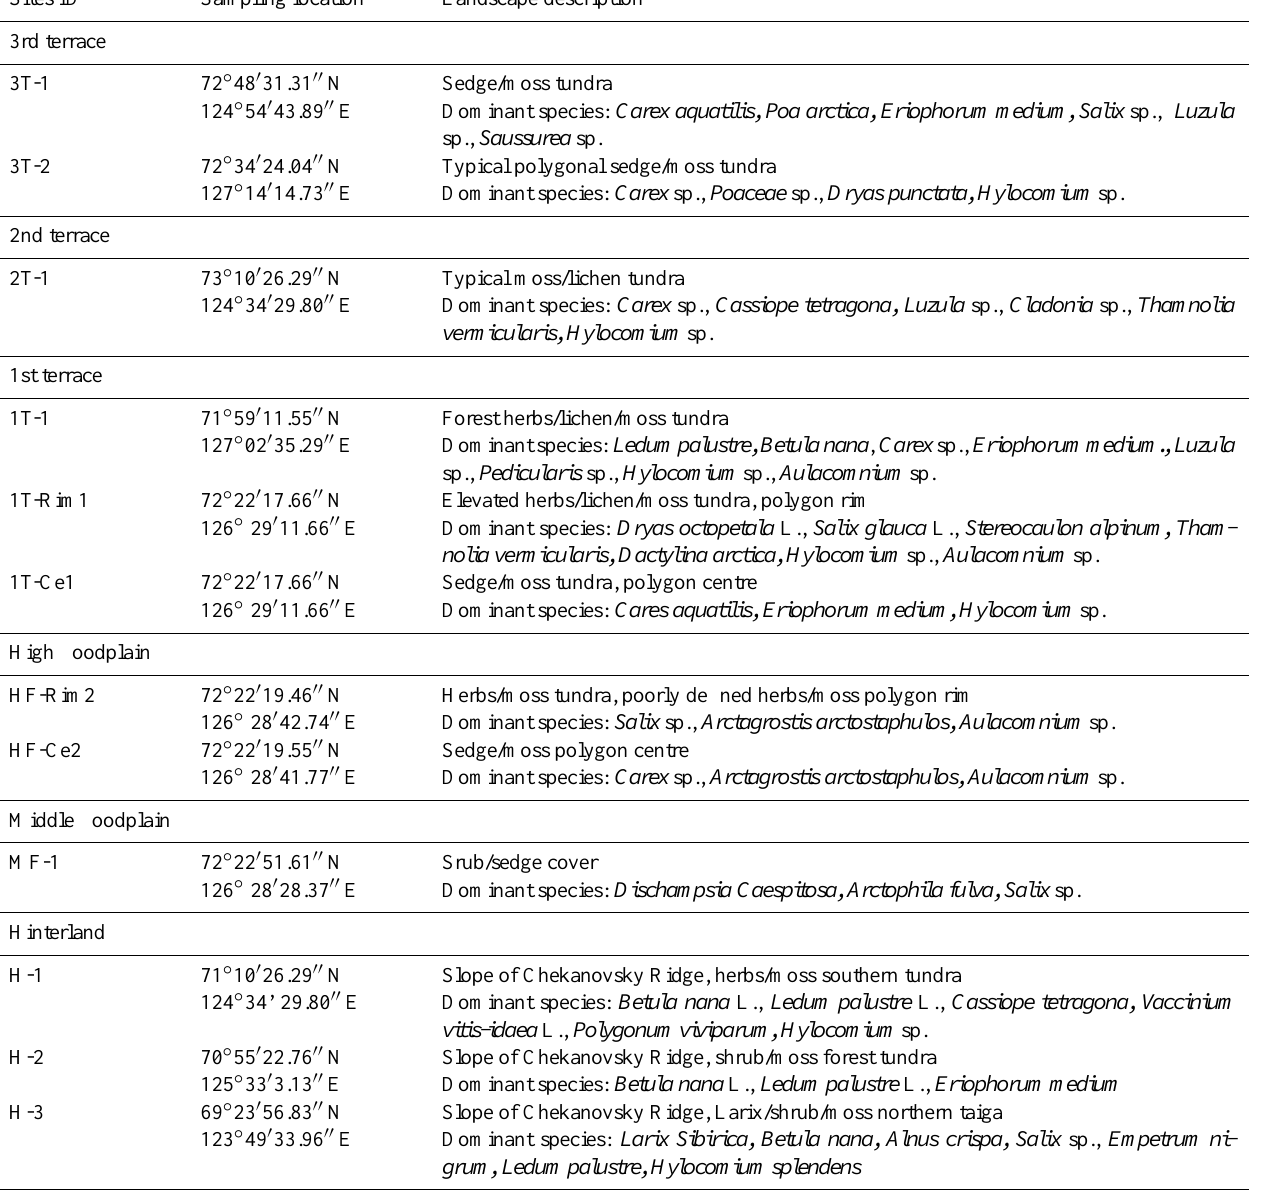
Table 1. General field information of investigation sites. Sites ID Sampling location Landscape